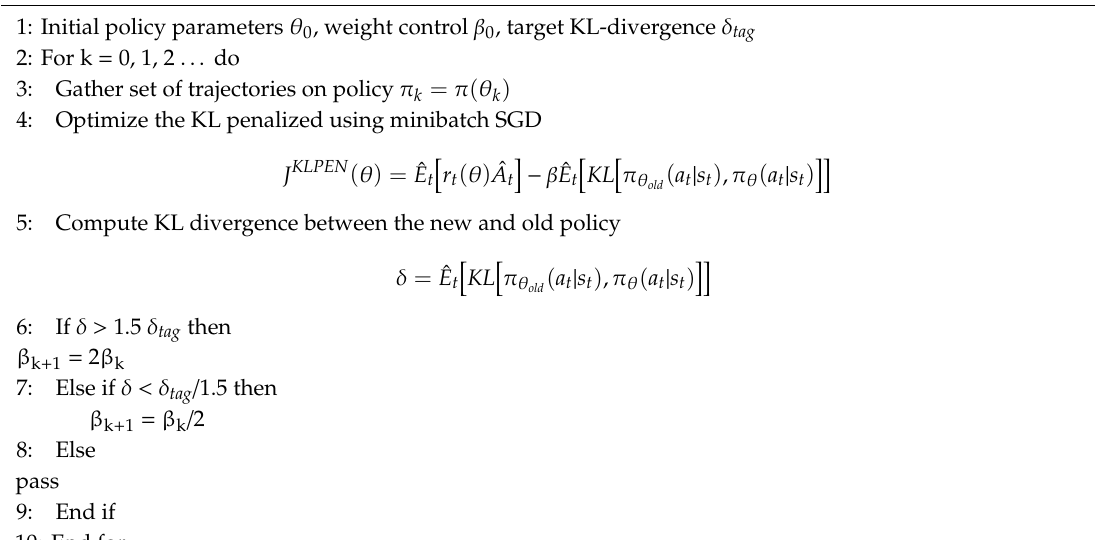
Figure 3. A typical A simulation of urban mobility (SUMO) at a non-signalized intersection.